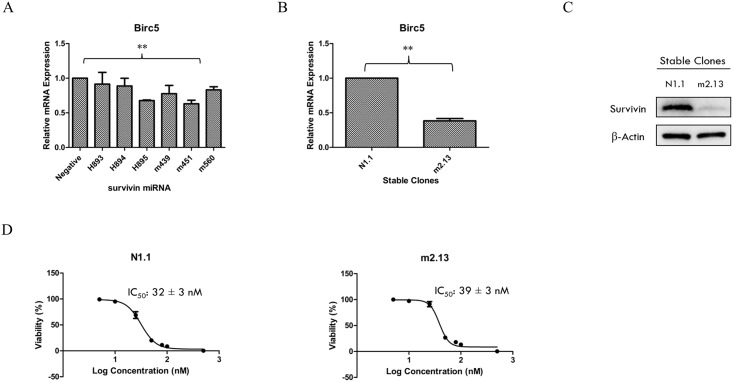
Survivin knockdown stable clones.(A) m451 plasmid achieved the greatest effect (37% knockdown) on the silencing of the survivin mRNA expression after transient transfection (transfection efficiency ~80%) when compared to the negative control plasmid. ** p < 0.01 from corresponding control. (B) m2.13 clone constitutively expressed survivin miRNA which cleaved survivin mRNA transcripts produced inside the cell and led to a survivin mRNA expression of only 38% compared to the negative clone, N1.1. ** p < 0.01 from corresponding control. (C) The protein expression of survivin in m2.13 was significantly lower compared to N1.1. (D) The growth inhibitory IC50s of YM155 on these clones were similar.